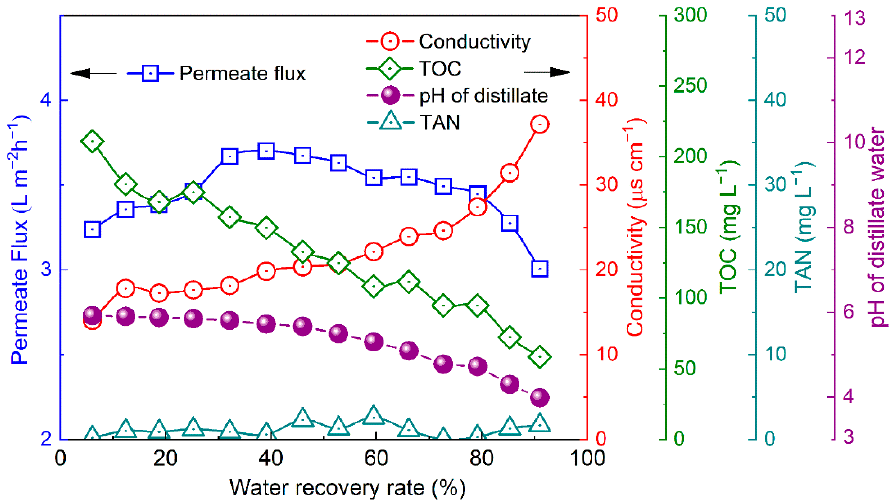
Figure 5. Changes in permeate flux, conductivity, and pH, as well as the concentrations of TOC and TAN with the water recovery rate (initial feed pH: 1.6, average temperature: 61 °C, permeate side pressure: 15.3 kPa).